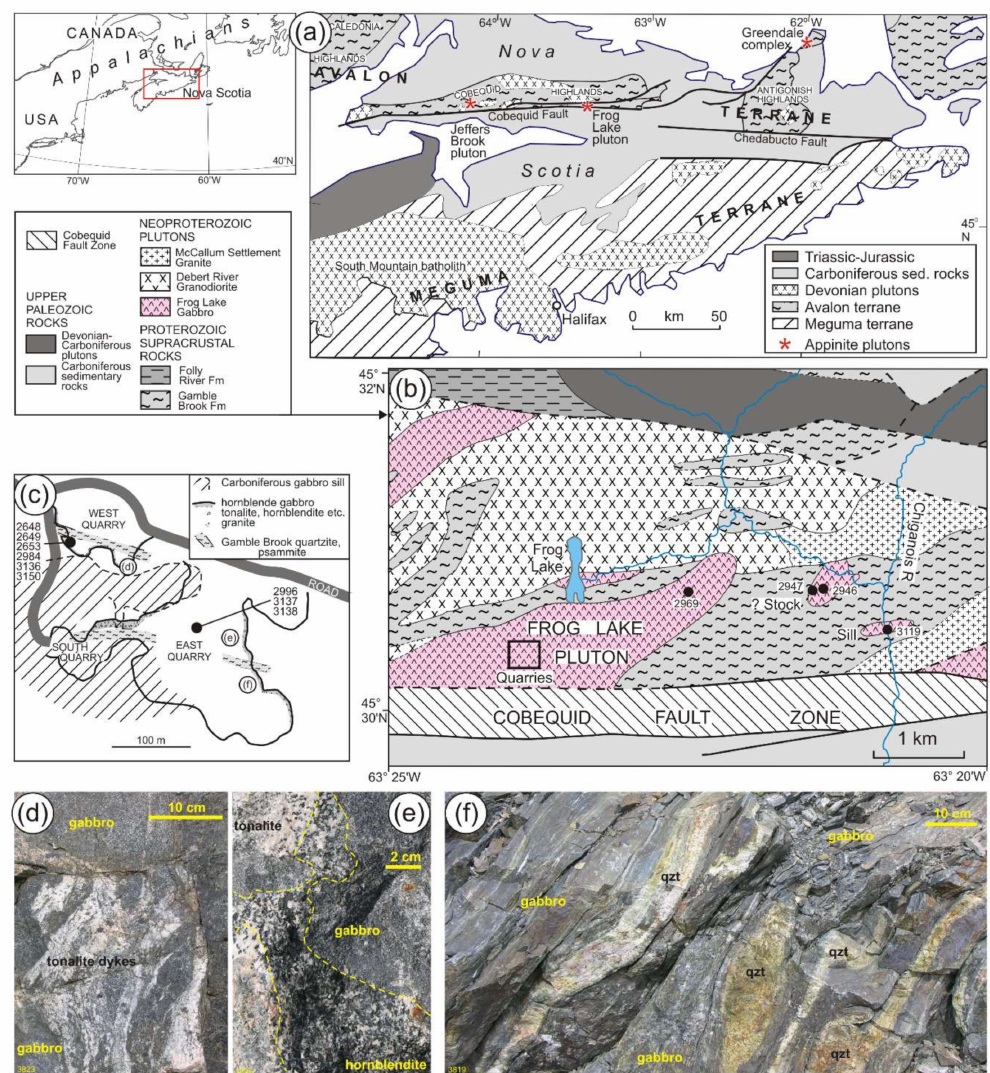
Figure 1. ( a ) Location map of the appinitic plutons in the Avalon terrane of Nova Scotia. The inset shows the location in eastern Canada. ( b ) Geological map of the Frog Lake pluton modified from Pe-Piper and Piper [3]. The rocks of the Cobequid Fault zone include sheared equivalents of rocks to the north; south of the Cobequid Fault zone, there are Carboniferous sedimentary rocks. Most of the analysed samples are from the quarries; other sample numbers are indicated on the map (solid circles). ( c ) Map of the Frog Lake quarries. This also shows the locations of samples and photographs ( d – f ). ( d ) Synmagmatic deformation of tonalite dykes in gabbro. ( e ) Gabbro with hornblendite and tonalite dykes. ( f ) Sheets of foliated gabbro between screens of